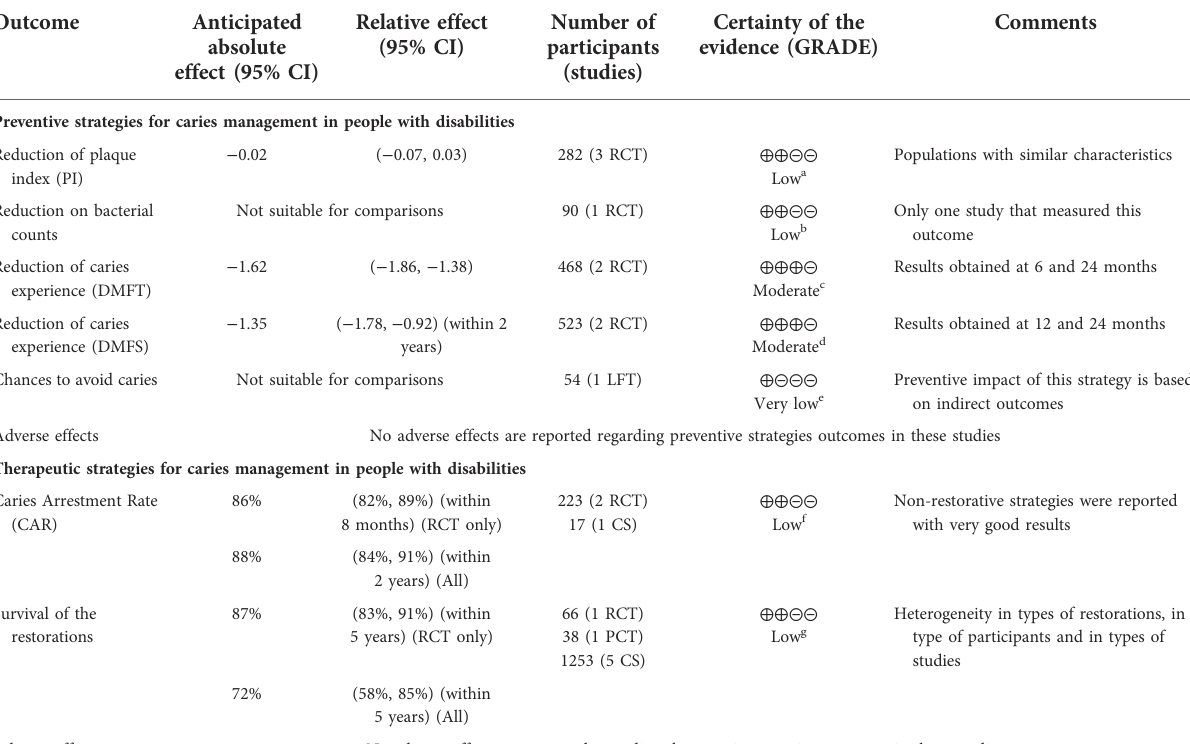
TABLE 2 Analysis of the certainty of the evidence by outcomes across studies based on GRADE